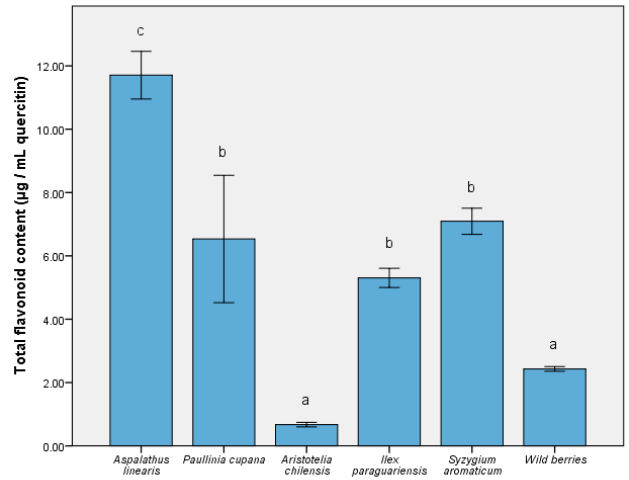
Figure 2. The total quantities of flavonoid compounds in the extracts. Different letters in each column represent significant statistical differences ( p ≤ 0.05) between extracts, n = 4.